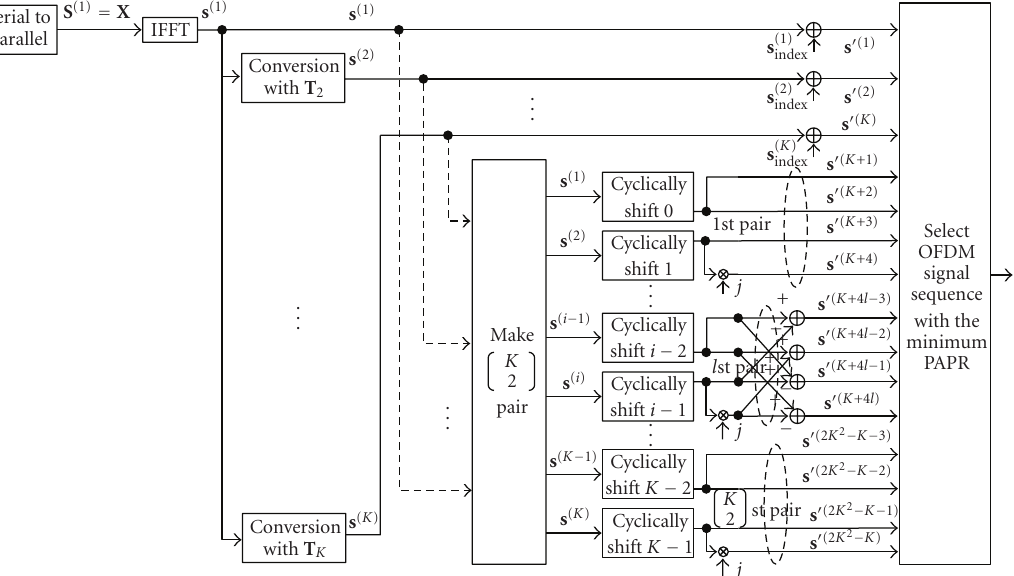
Figure 4: Block diagram of the novel SLM